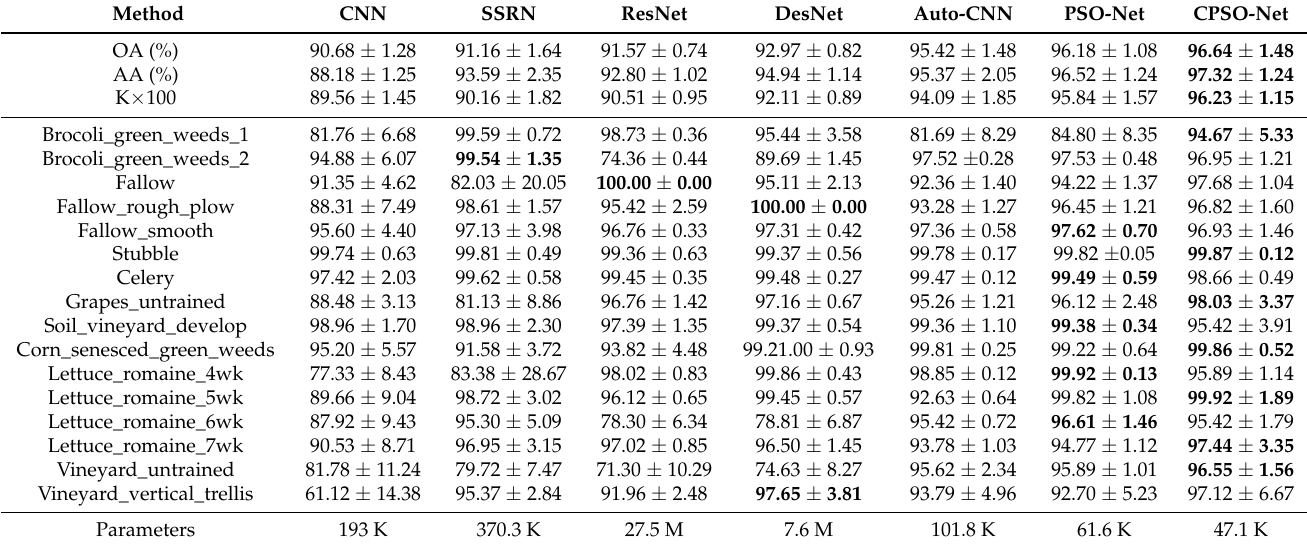
Parameters Table 4. Classification accuracy with bolding the best accuracy based on the biased Salinas dataset, run five times.